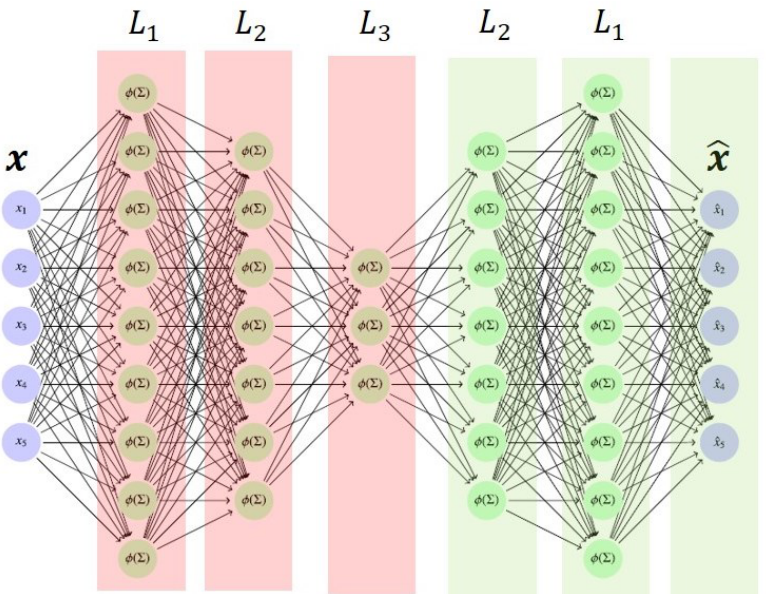
Figure 4. Schematic illustration of architecture of an autoencoder with subspace transfer. Parameters from the first two layers are fixed (red), while last two layers are retrained on the target data